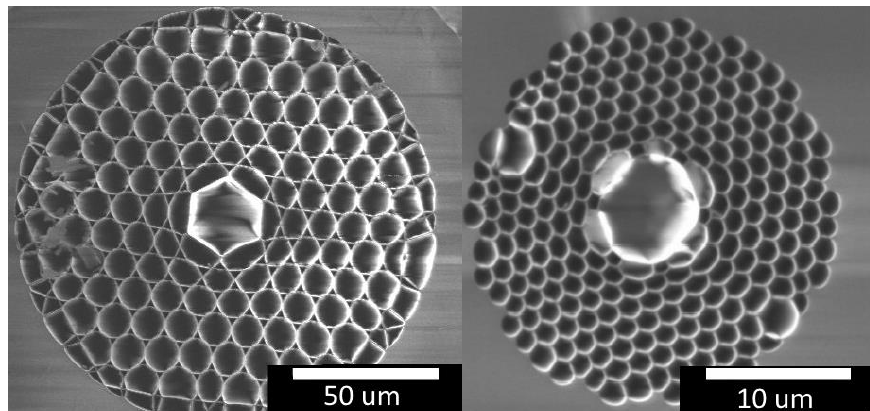
Figure 1. Scanning electron microscopy images of the kagomé-PCF ( left ) and a photonic bandgap PCF ( right ). The core diameters are 12 µm and 2.25 µm, respectively. Please note the 5-fold difference in magnification.